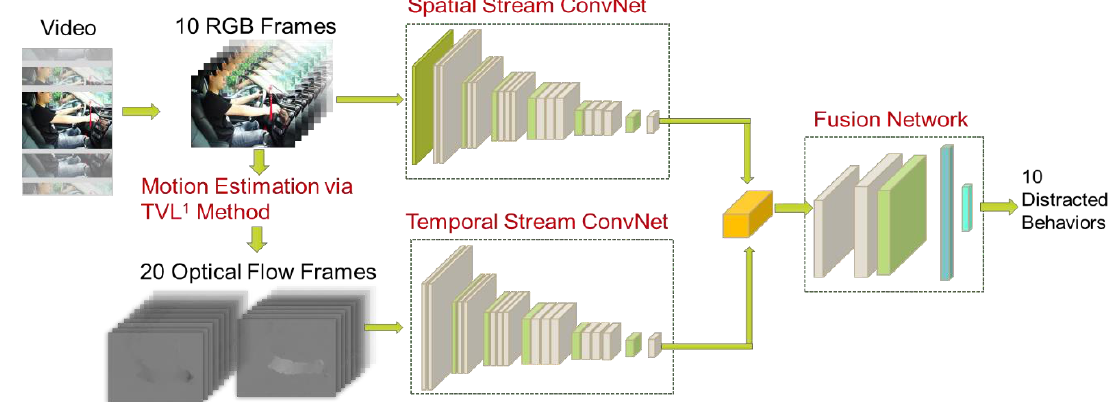
Figure 1. Driver distraction system flowchart.